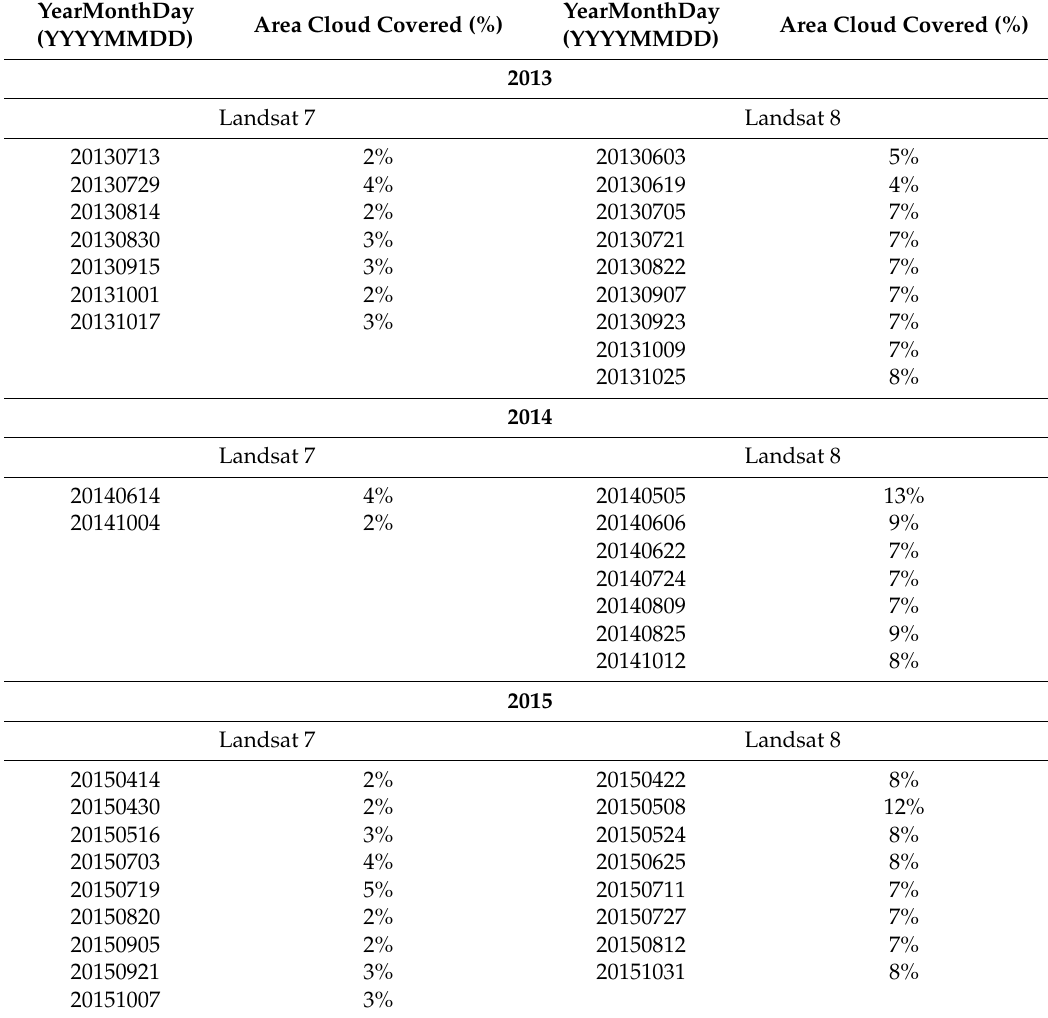
Table 2. List of Landsat images used in this study. Path/row of the image was